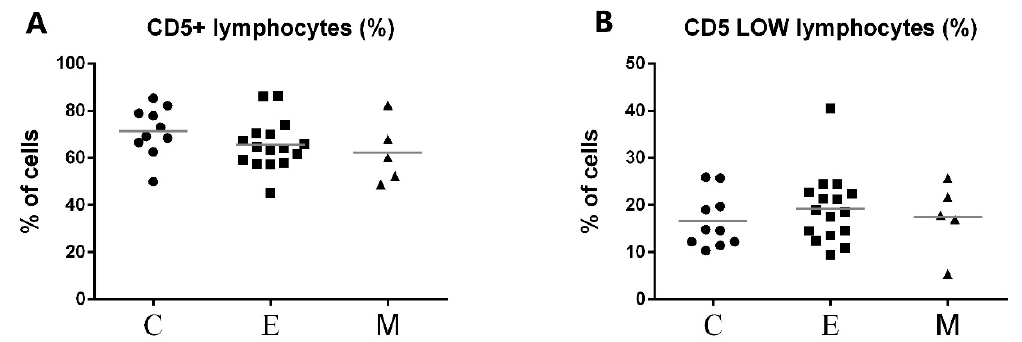
Figure 3. Flow cytometric results showing the mean values of CD5+ ( A ) and CD5 low ( B ) lymphocyte percentages in peripheral blood of female dogs with malignant tumors of diverse origin and control group. Mean values of CD5+ lymphocytes percentage ( ± SD) in female dogs with tumors of epithelial origin (E); female dogs with tumors of mesenchymal origin (M); and the control group (C).